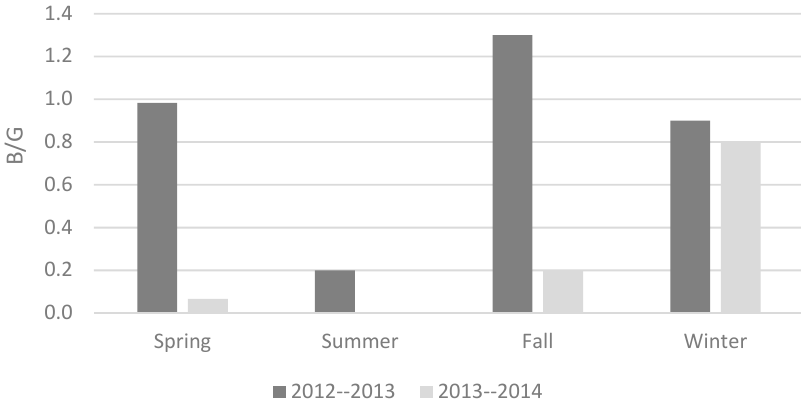
Figure 1. The blue to green water (B/G) ratio for a Q. ilex coppice forest in 2012–2013 and 2013–2014. Precipitation values were 534 mm and 271 mm for 2012–2013 and 2013–2014, respectively.